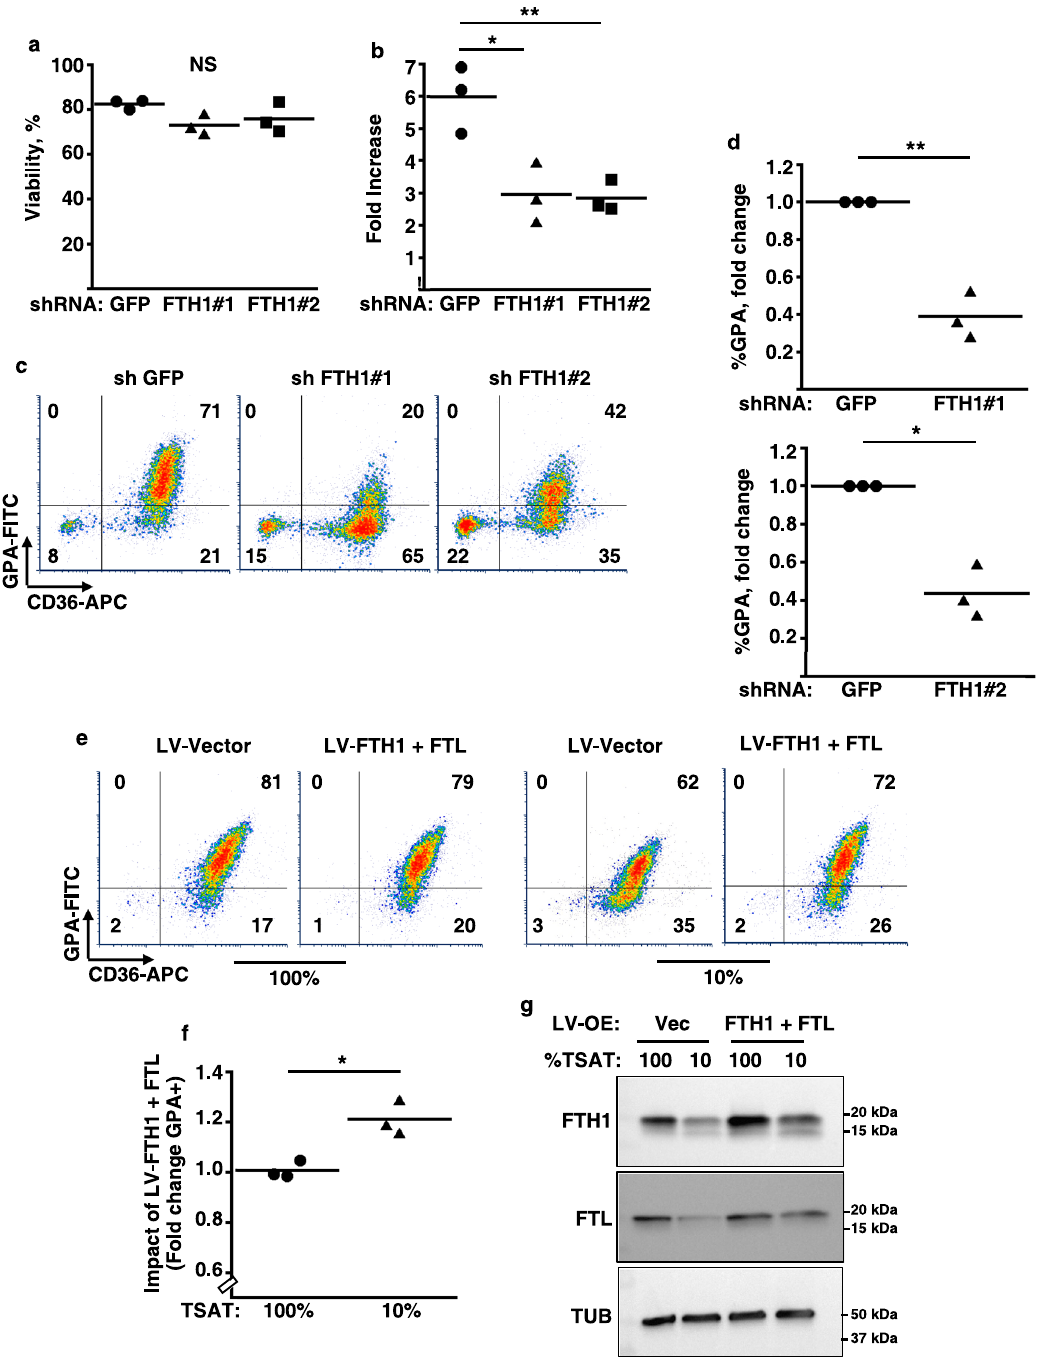
Fig. 4 Implication of FTH1 in the erythroid iron restriction response. a , b In fl uence of FTH1 levels on viability and proliferation. Graphs: mean % viable cells and fold increases in cell number for human CD34 + progenitors transduced with lentiviral shRNA vectors targeting either green fl uorescent protein (GFP) or ferritin heavy chain (FTH1), and cultured 4 days in iron-replete erythroid medium. Error bars, SEM; n = 3 biologically independent experiments; *, ** P = 0.011, 0.009, one-way ANOVA with Tukey post hoc. NS not signi fi cant. GPA glycophorin A. c In fl uence of FTH1 levels on erythroid differentiation as determined by fl ow cytometry on cells treated as in a . d Mean fold change in GPA + cells associated with lentiviral transductions and 4 days culture in iron- replete erythroid medium. Error bars, SEM; n = 3 independent experiments; *, ** P = 0.019, 0.013, unpaired two-sided Student ’ s t test. Note: most experiments separately assessed FTH1#1 and FTH1#2. e Distinct consequences of ferritin enforcement in iron-replete versus iron-restricted progenitors. Flow cytometry analysis of CD34 + progenitors transduced with lentiviral (LV) expression vectors for ferritin heavy (FTH1) and light (FTL) chains followed by 4 days culture in iron-replete (100% TSAT) or de fi cient (10% TSAT) erythroid medium. f Mean fold change in GPA + cells associated with ferritin enforcement in cells cultured as in e . Error bars, SEM; n = 3 independent experiments; * P = 0.02, unpaired two-sided Student ’ s t test. g Ferritin levels in cells transduced and cultured as in e and f , as assessed by immunoblot. LV-OE lentiviral overexpression; Vec vector. Representative results from three independent experiments. See also Supplementary Fig. 8. Source data are provided as a Source data fi le.